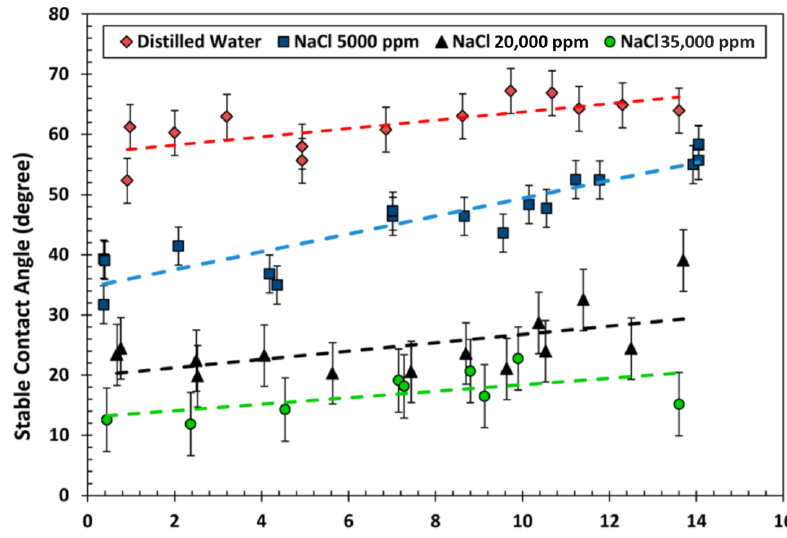
Figure 10. Contact angle measurements for sandstone after being saturated with oil, brine and CO 2 at 45 ◦ C